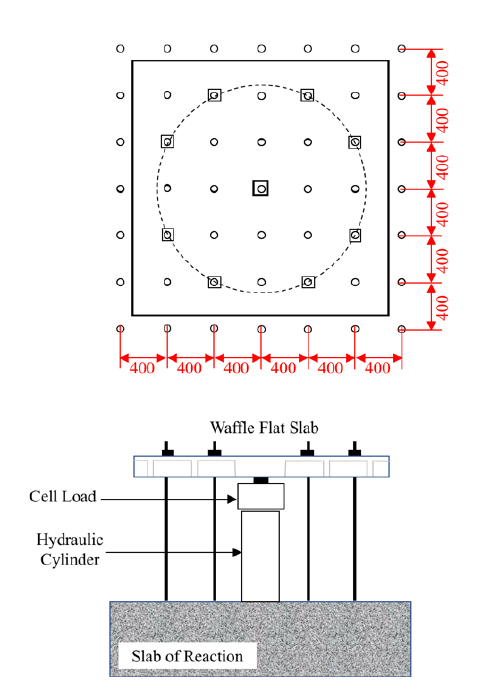
Figure 5. Scheme of the test (units in mm)